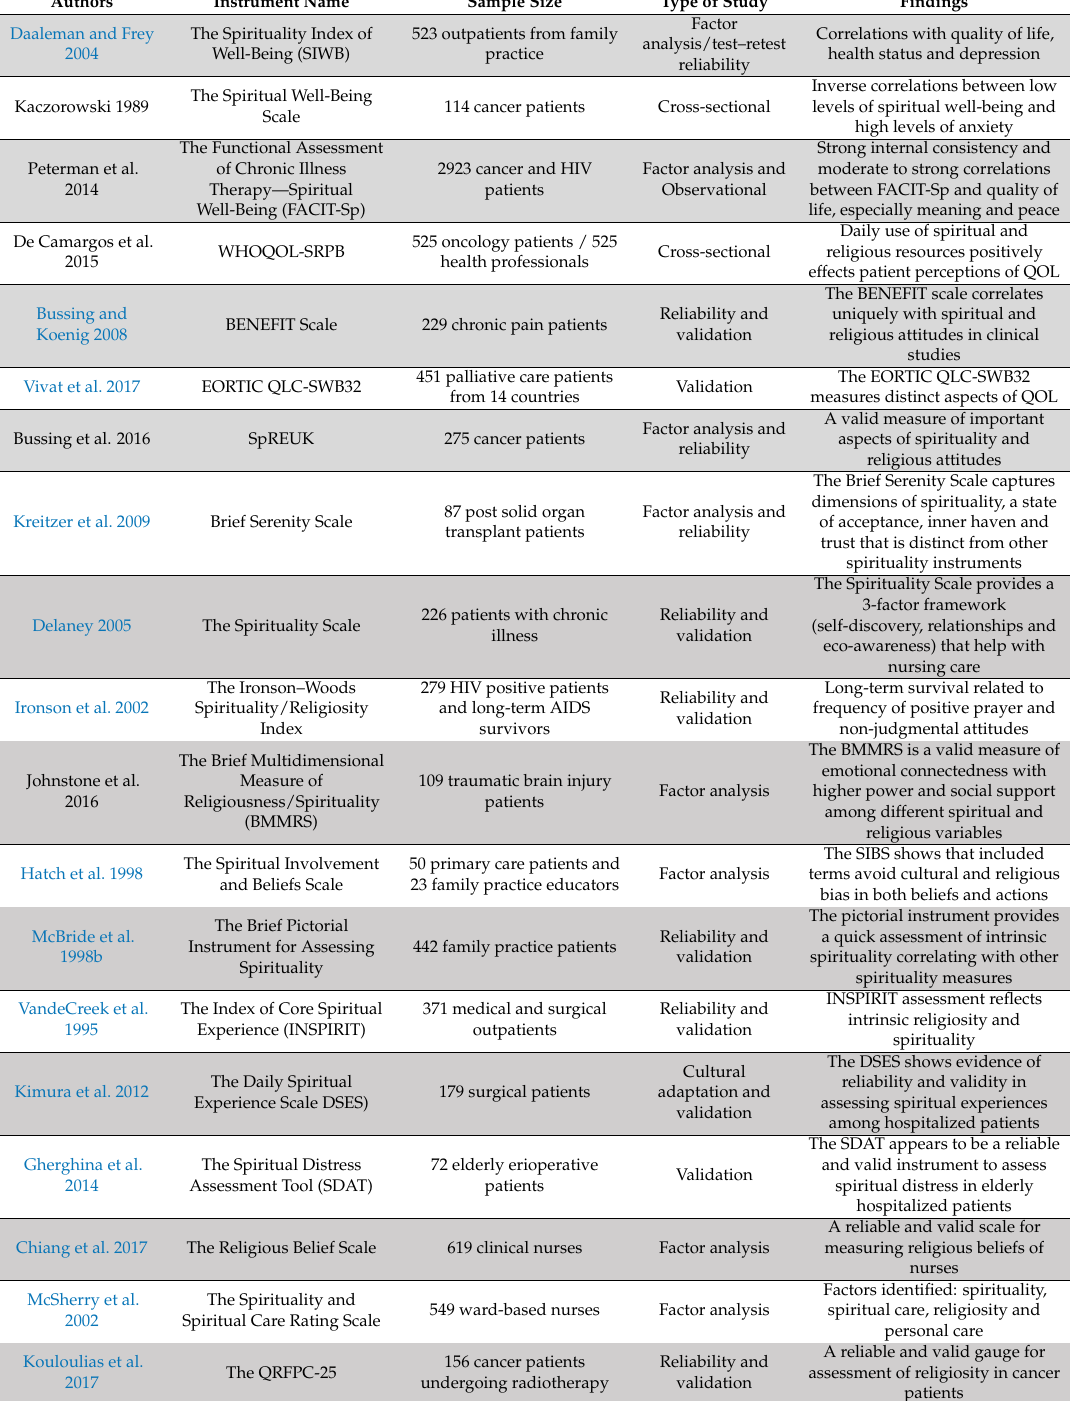
Table 2. Spirituality, spiritual well-being, religiosity and religious beliefs measures used in clinical